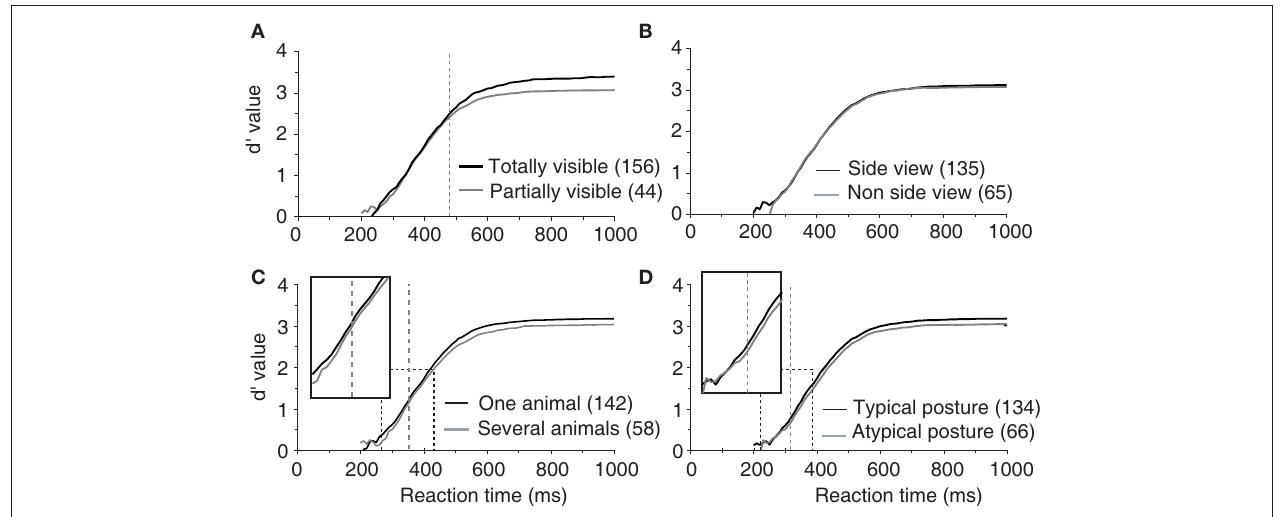
typical versus atypical. For A–D, as in previous figures, vertical doted lines represent the earliest latency at which a statistically significant effect was seen on accuracy (479 ms for visibility; 353 ms for the number of animal; 316 ms for the animal posture). Numbers in brackets indicate the number of stimuli considered in each class. Boxes show close-up views of the d ′ curves within the dashed